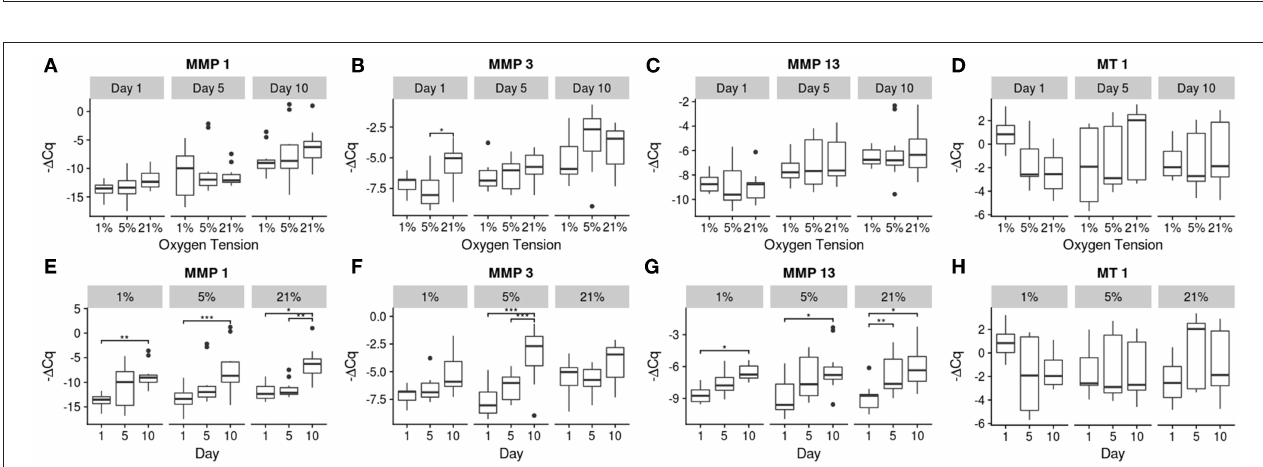
FIGURE 4 | Gene expression of the anabolic genes using - 1 C q values. The top row (A–C) contains between oxygen tension group comparisons over the days, while the bottom row (D–F) contains changes over time within each oxygen tension group. Significance shown as * p ≤ 0.05 and ** p ≤ 0.01.